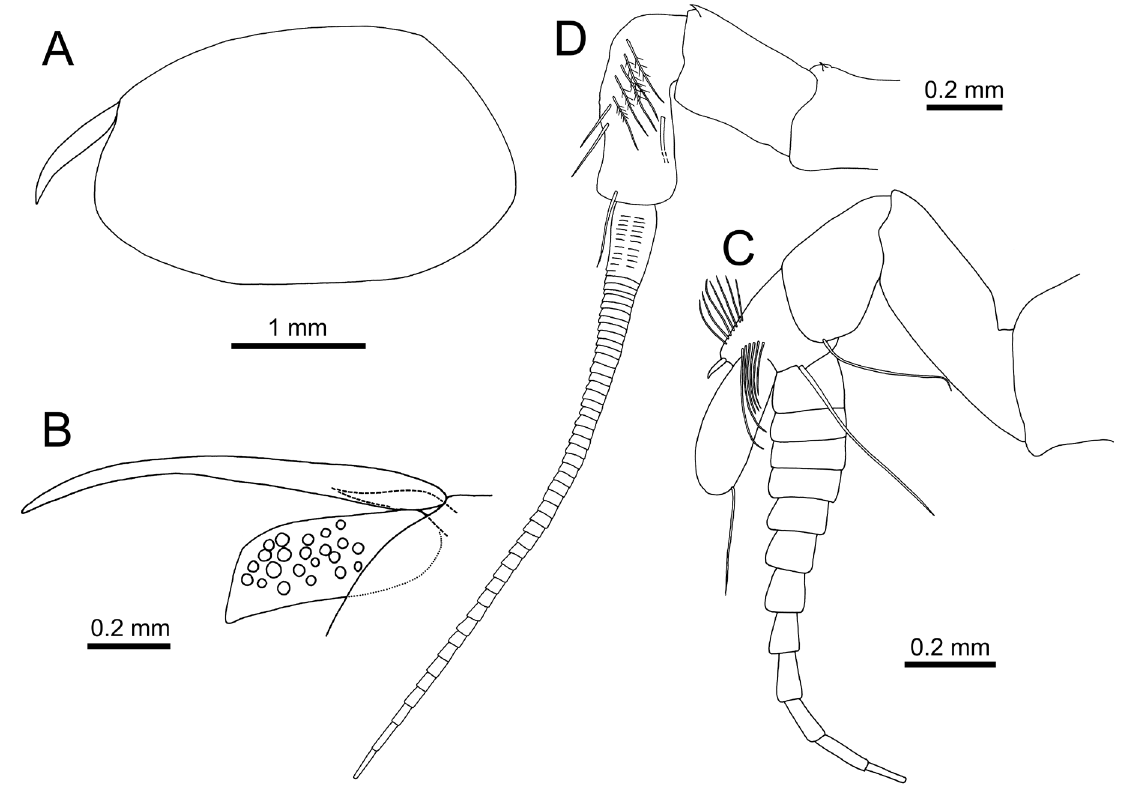
Fig. 9. Nebalia abyssicola Fage, 1929. Male (DBUA0001676.02.A). A . Rostrum and carapace, lateral view. B . Rostrum and eye, lateral view. C . Antennule, lateral view. D . Antenna, lateral view. C–D: only selected setae